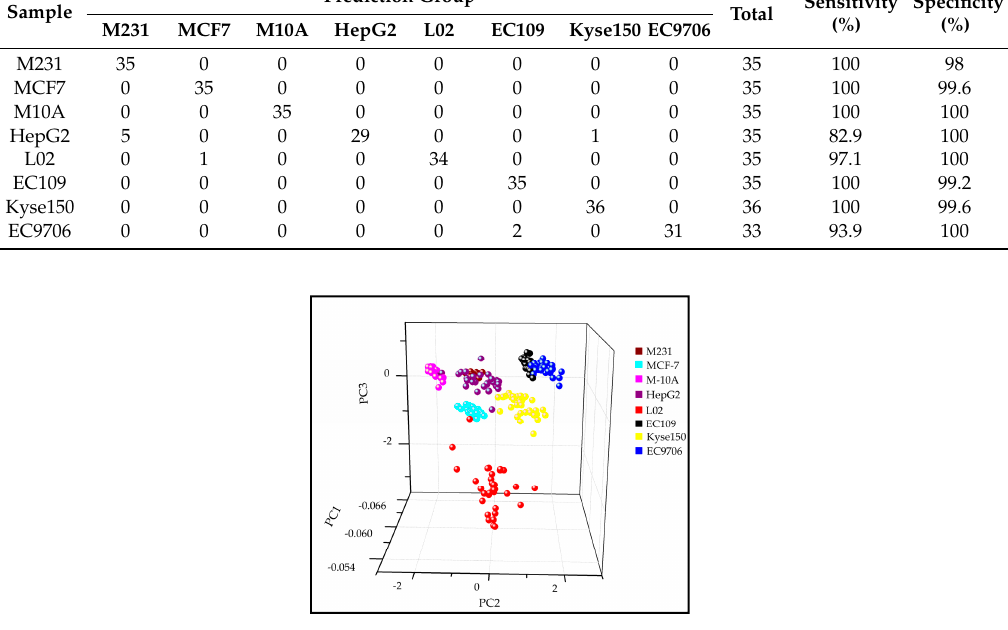
Figure 5. Principal component analysis of Exo-SERS data sets. The 3D scatter plot of PC1 (29.19%), PC2 (15.75%), and PC3 (11.19%) for the SERS spectra obtained from eight exosome subtypes by applying the spectral range of 500–1600 cm − 1 .